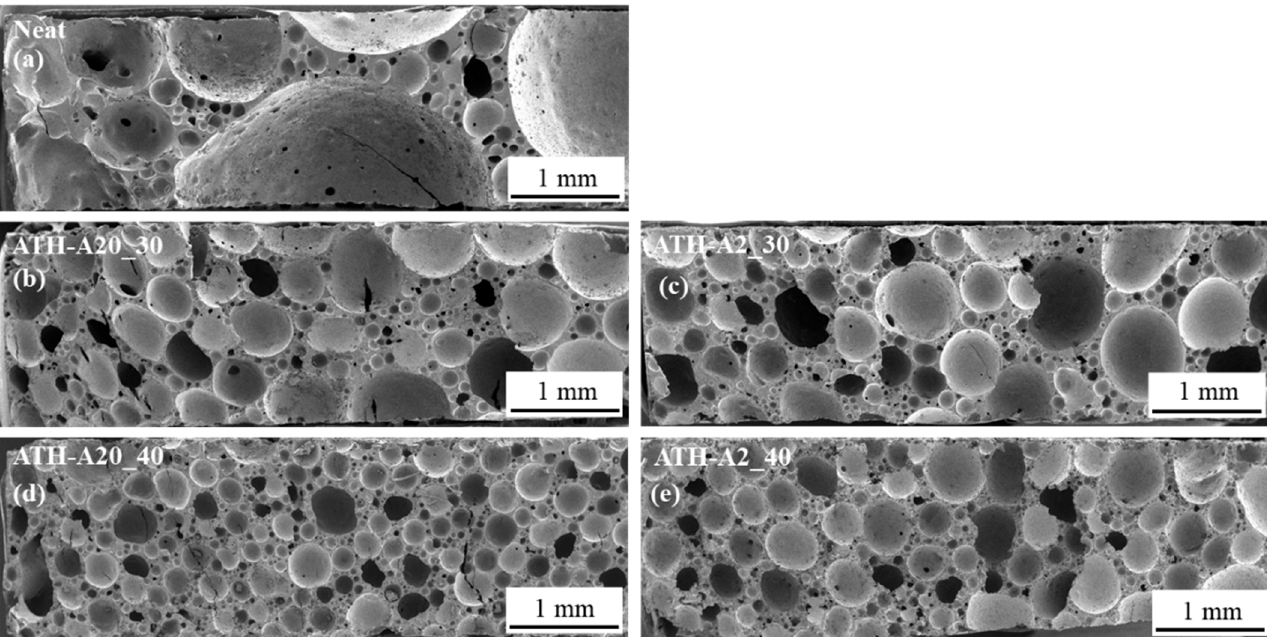
Figure 2. SEM images taken from EN/B-IPDA foams without particle modification, Neat ( a ), with 30 wt.% ATH ( b , c ) and 40 wt.% ATH of different particle size A20 ( d ) and A2 ( e ).